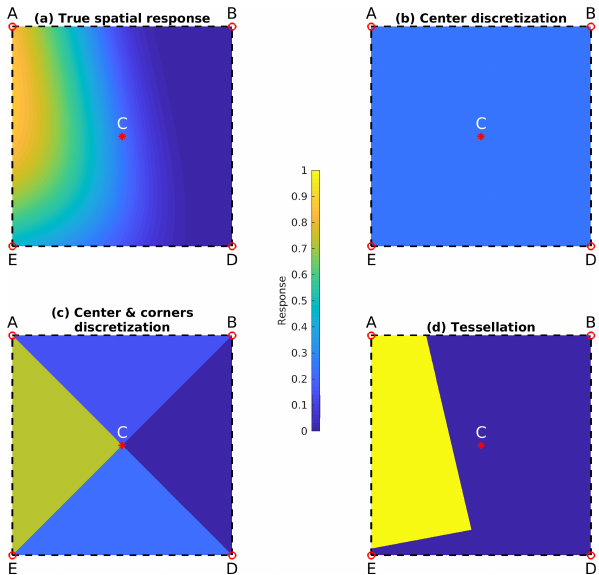
Figure B1. (a) An ideal spatial response function constructed us- ing OMI across-track no. 30 pixel boundary and relatively sharp edges ( k 1 = 12, k 2 = 6, k 3 = 1). Only the overlapping portion with a 5km × 5km grid cell (square ABDE) is shown. C is the grid cen- ter. (b) Simple discretization scheme, where the grid cell value is approximated by the spatial response at central position C. (c) The spatial response is discretized at both grid center and grid corners. See text for details. (d) Tessellation, where the spatial response is assumed to be unity inside the pixel boundary and zero outside. The polygons are color-coded by the spatial response